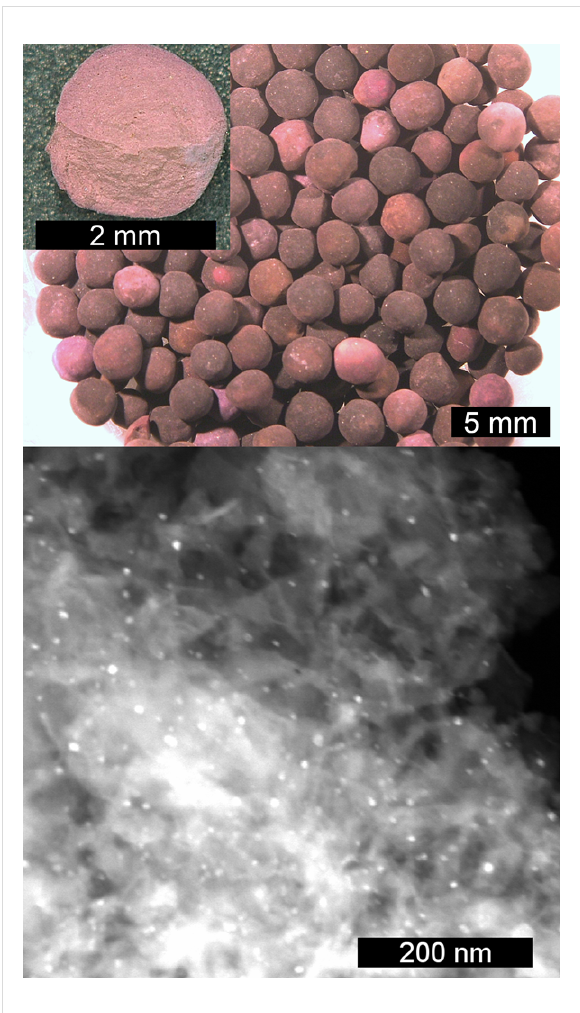
Figure 1: Top: Picture of molecular sieve beads (zeolite X) loaded with gold-NPs, from a batch used for ethanol purification, taken with an optical microscope. The inset shows a micrograph of a bead with a fresh breakage at the lower side, the color of which indicates that the NPs are located not only on the surface but also within the beads. Bottom: Scanning transmission electron micrograph of gold-NPs (bright spots) immobilized on zeolite